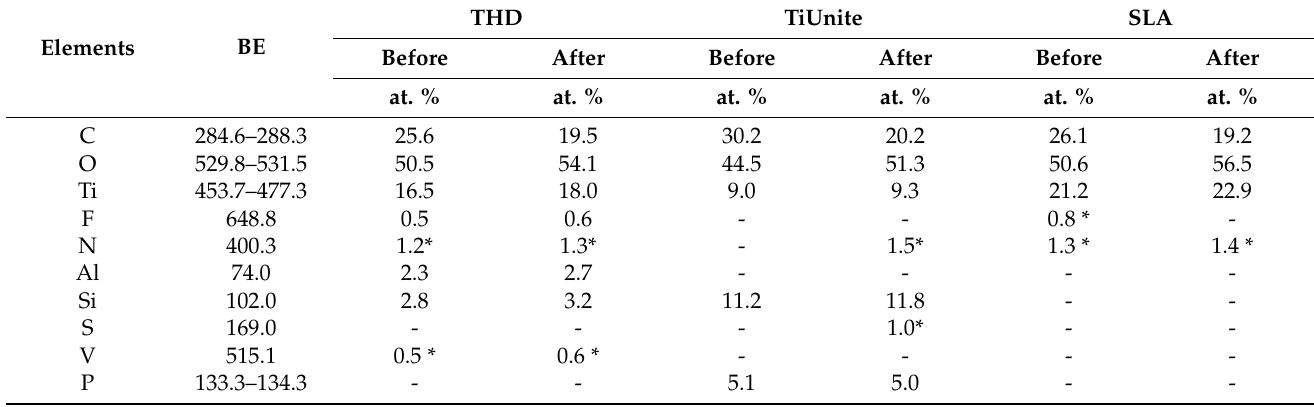
Table 1. Atom concentration rate (at. %) and binding energies (BE) of elements before and after LED-based UVC light irradiation. These are the results of the central point, between the 6th and 7th thread in the THD, and 4th and 5th thread in the TiUnite and SLA, since the data of the other measurements do not differ.